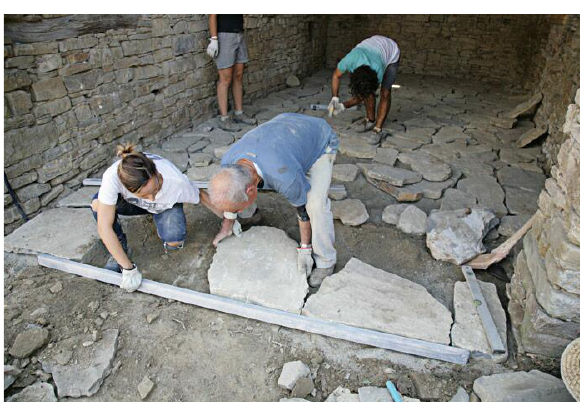
Figure 6. Laying a traditional stone